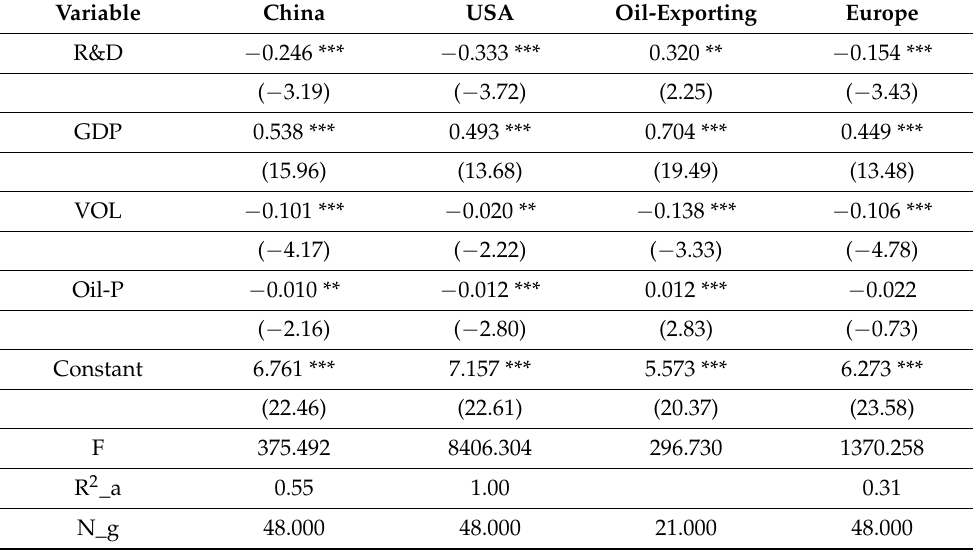
Table 3. Results from the Driscoll–Kraay